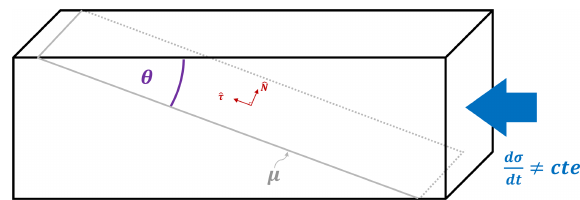
Figure 1. Schematic description of the nonconstant uniaxial stresses in presence of a fault with friction coefficient µ and dip angle θ . This schematic description is similar to the experimental setup for pressure stimulated currents (PSC; Kyriazopoulos et al., 2011).